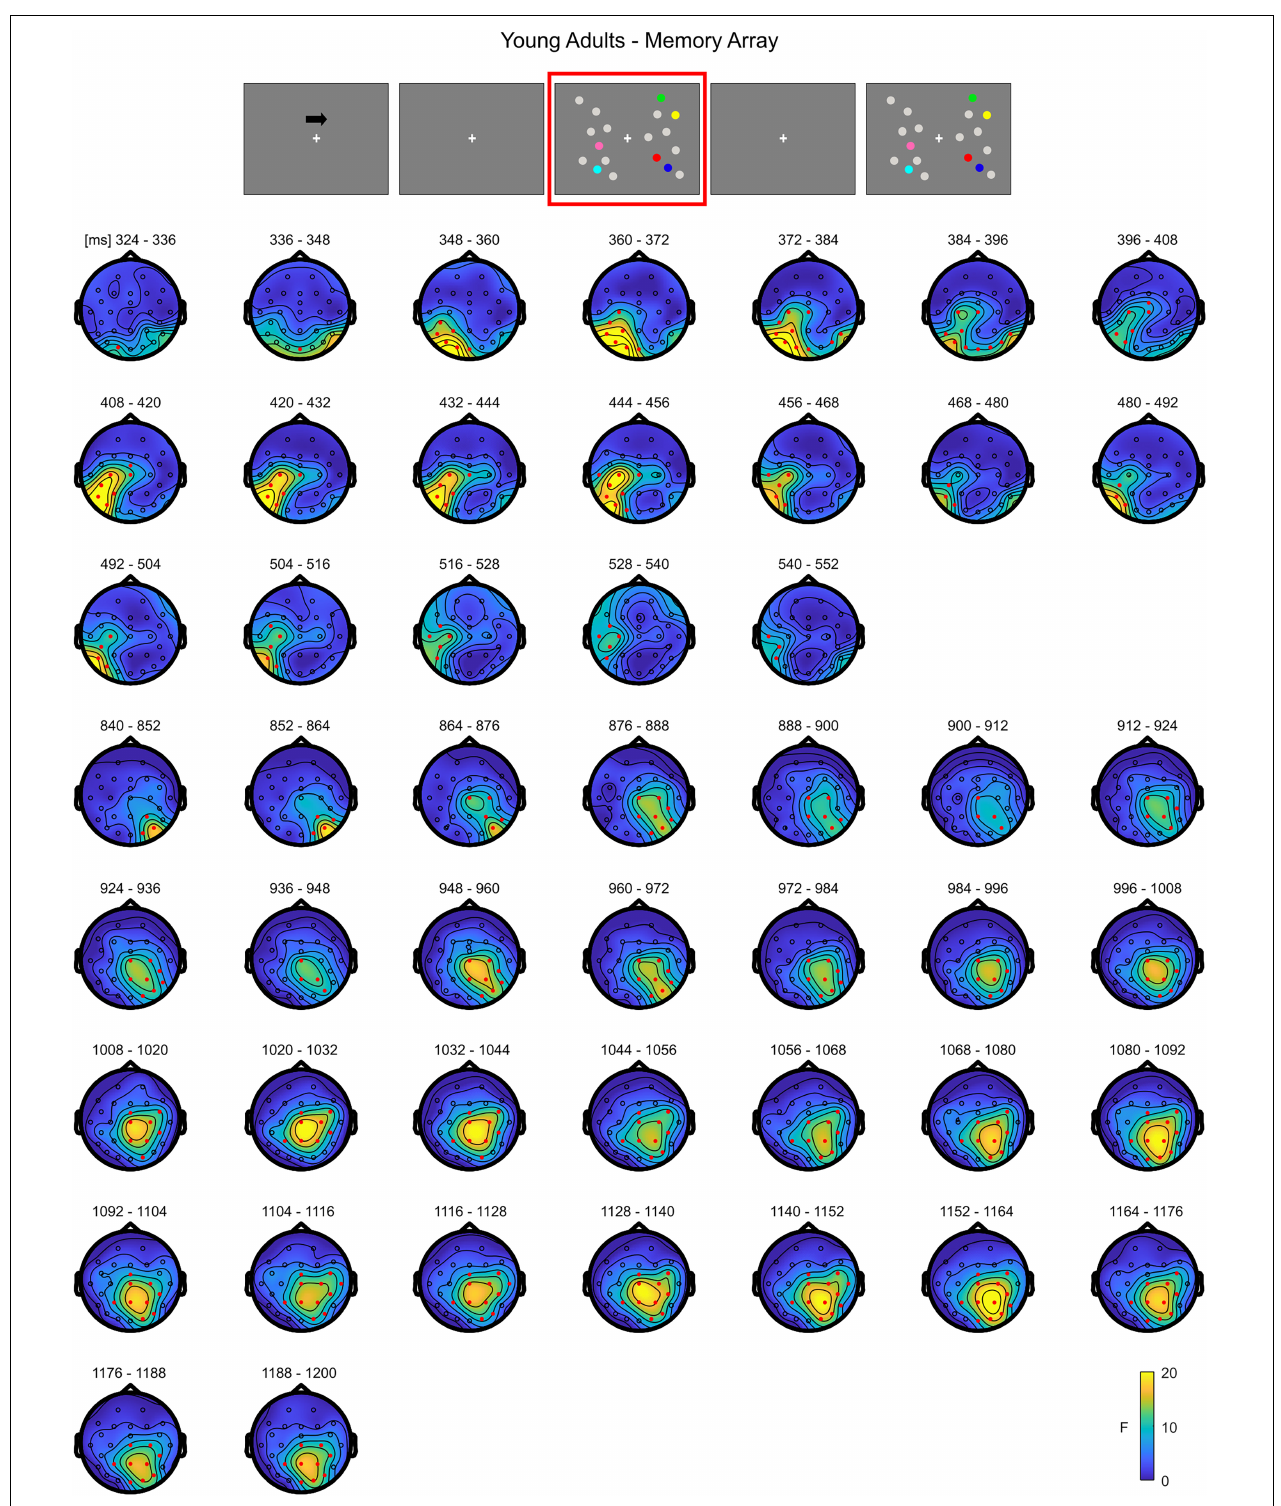
FIGURE 2 | Cluster-based permutation ANOVA results during memory retention in the Younger group. The spatio-temporal evolution of the significant Load effect is represented through topographical maps of the clusters averaged in bins of 12 ms. Only significant time windows are depicted (for the complete time course, see Supplementary Figure 1 ). Red dots represent the significant effect. The color bar represents the range of F -values. Left and right channels are set as contralateral and ipsilateral to targets, respectively.